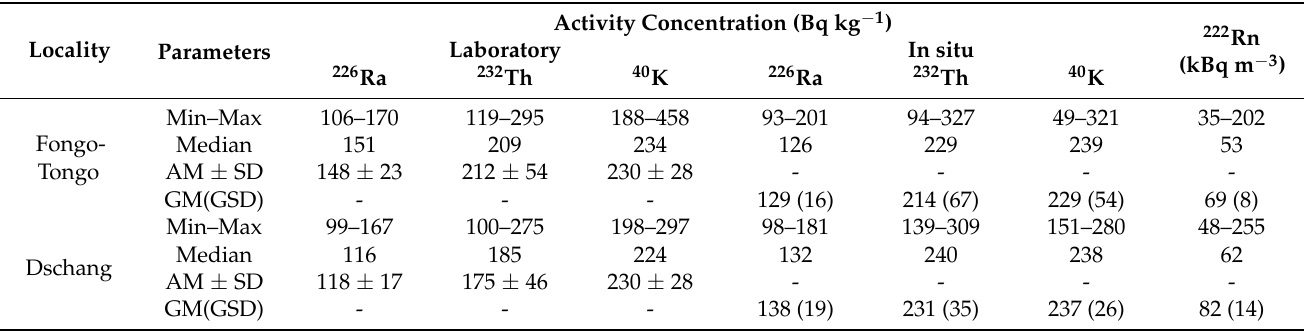
Table 2. Statistical parameters of 226 Ra, 232 Th, 40 K, and 222 Rn concentrations obtained by in situ and laboratory measurements for the localities of Dschang and